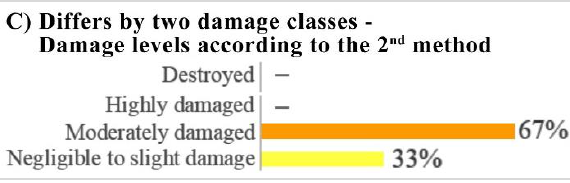
Figure 15. Difference by two damage classes between the two DDEs: percentage of buildings that had a certain damage class according to the assessment of the 2 nd